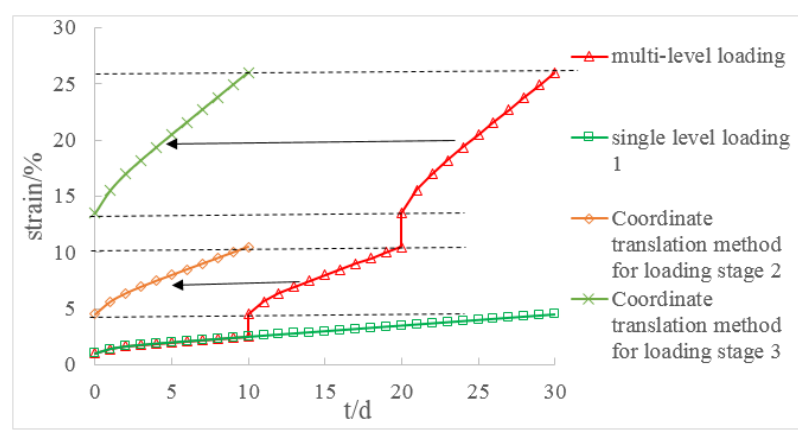
Figure 4. Data analysis of creep deformation by coordinate translation method.